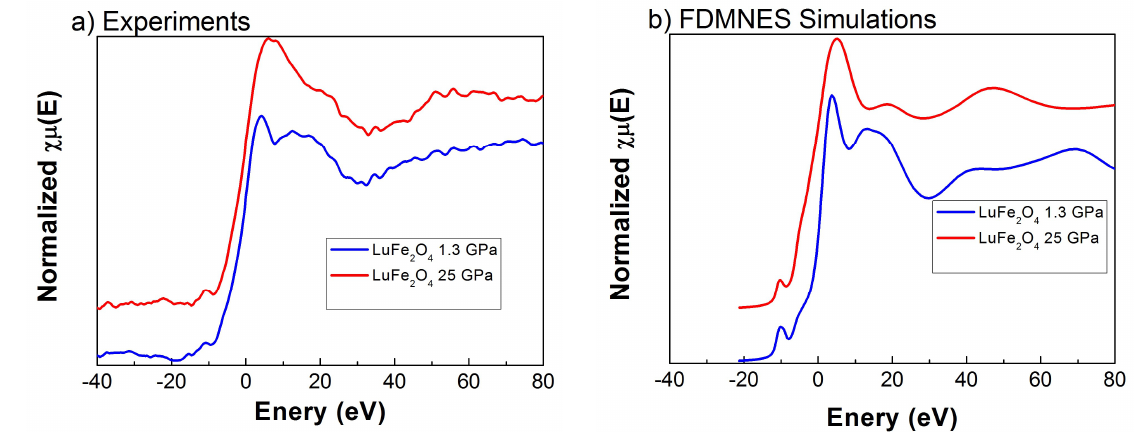
Figure 14. Comparison between low-pressure (1.3 GPa) and high-pressure (25 GPa) ( a ) experimental and ( b ) simulated X-ray absorption spectra of LuFe 2 O 4 at the K -edge.